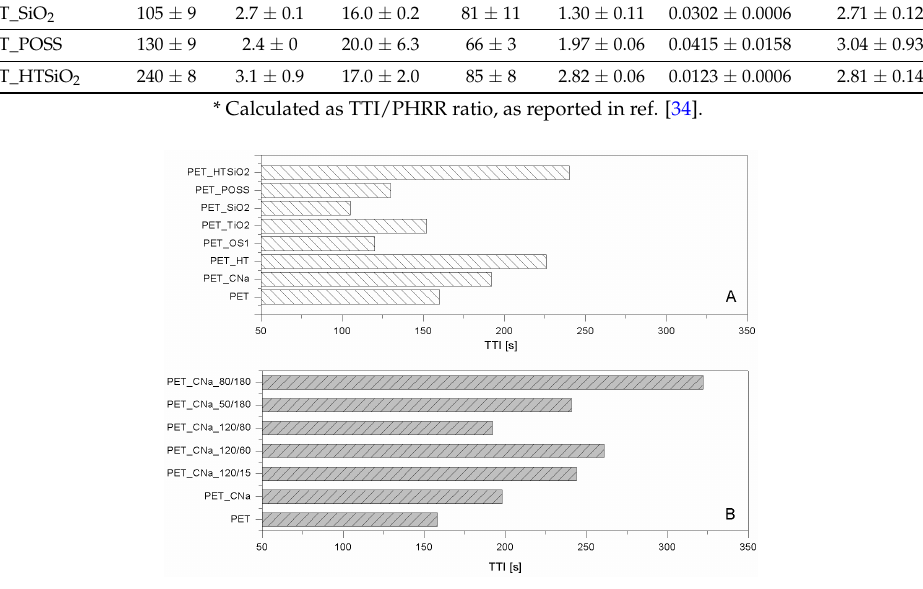
Figure 2. TTI values of nanoparticle (NP)-treated polyethylene terephthalate (PET) fabrics ( A ) and treated initially by plasma and then with CNa suspension ( B ) [33,35]. Data obtained by cone calorimetry at 35 kW/m 2 .